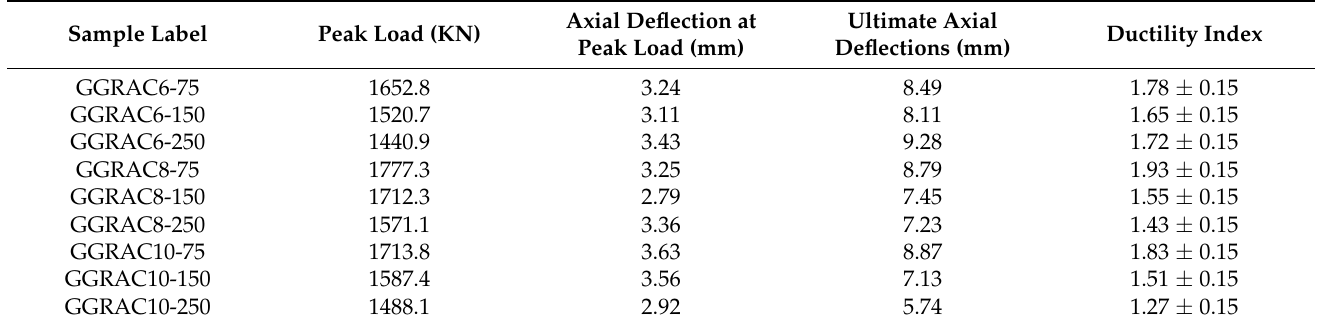
Table 5. Testing